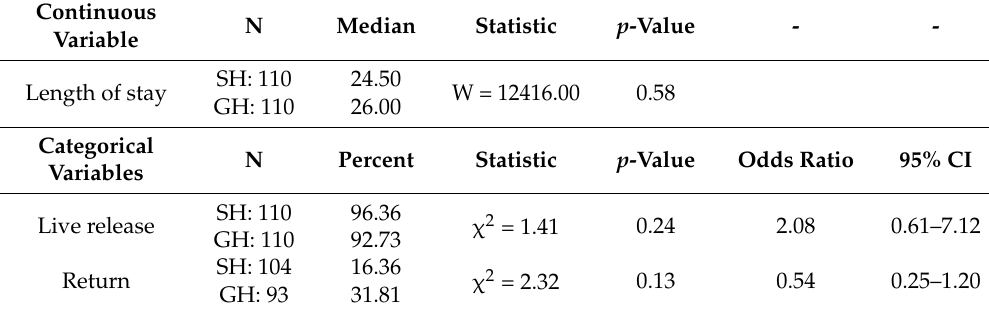
Table 2. Summary of outcome analyses. There were no significant differences between